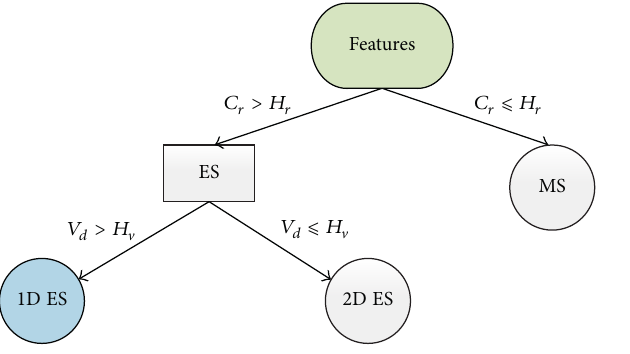
Figure 8: The DT structure for recognition of 1D ES.